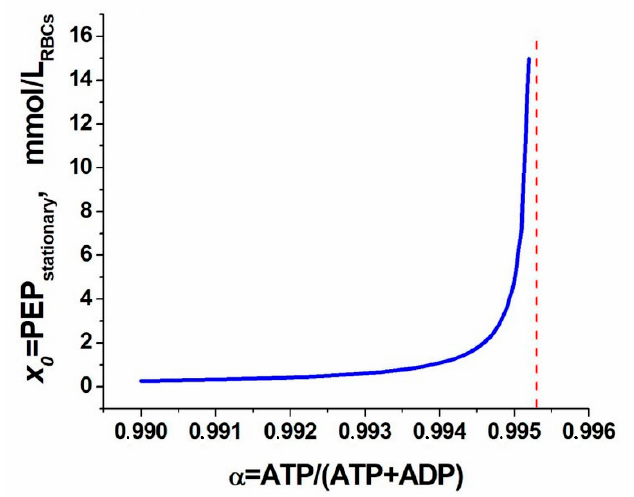
Figure 5. Dependence of the stationary concentration of PEP ( x 0 ) in the simplified metabolic system (Equations (8)–(10)) on the ATP fraction ( α ) in the pool of adenylates. The vertical line is the asymptote of the curve.